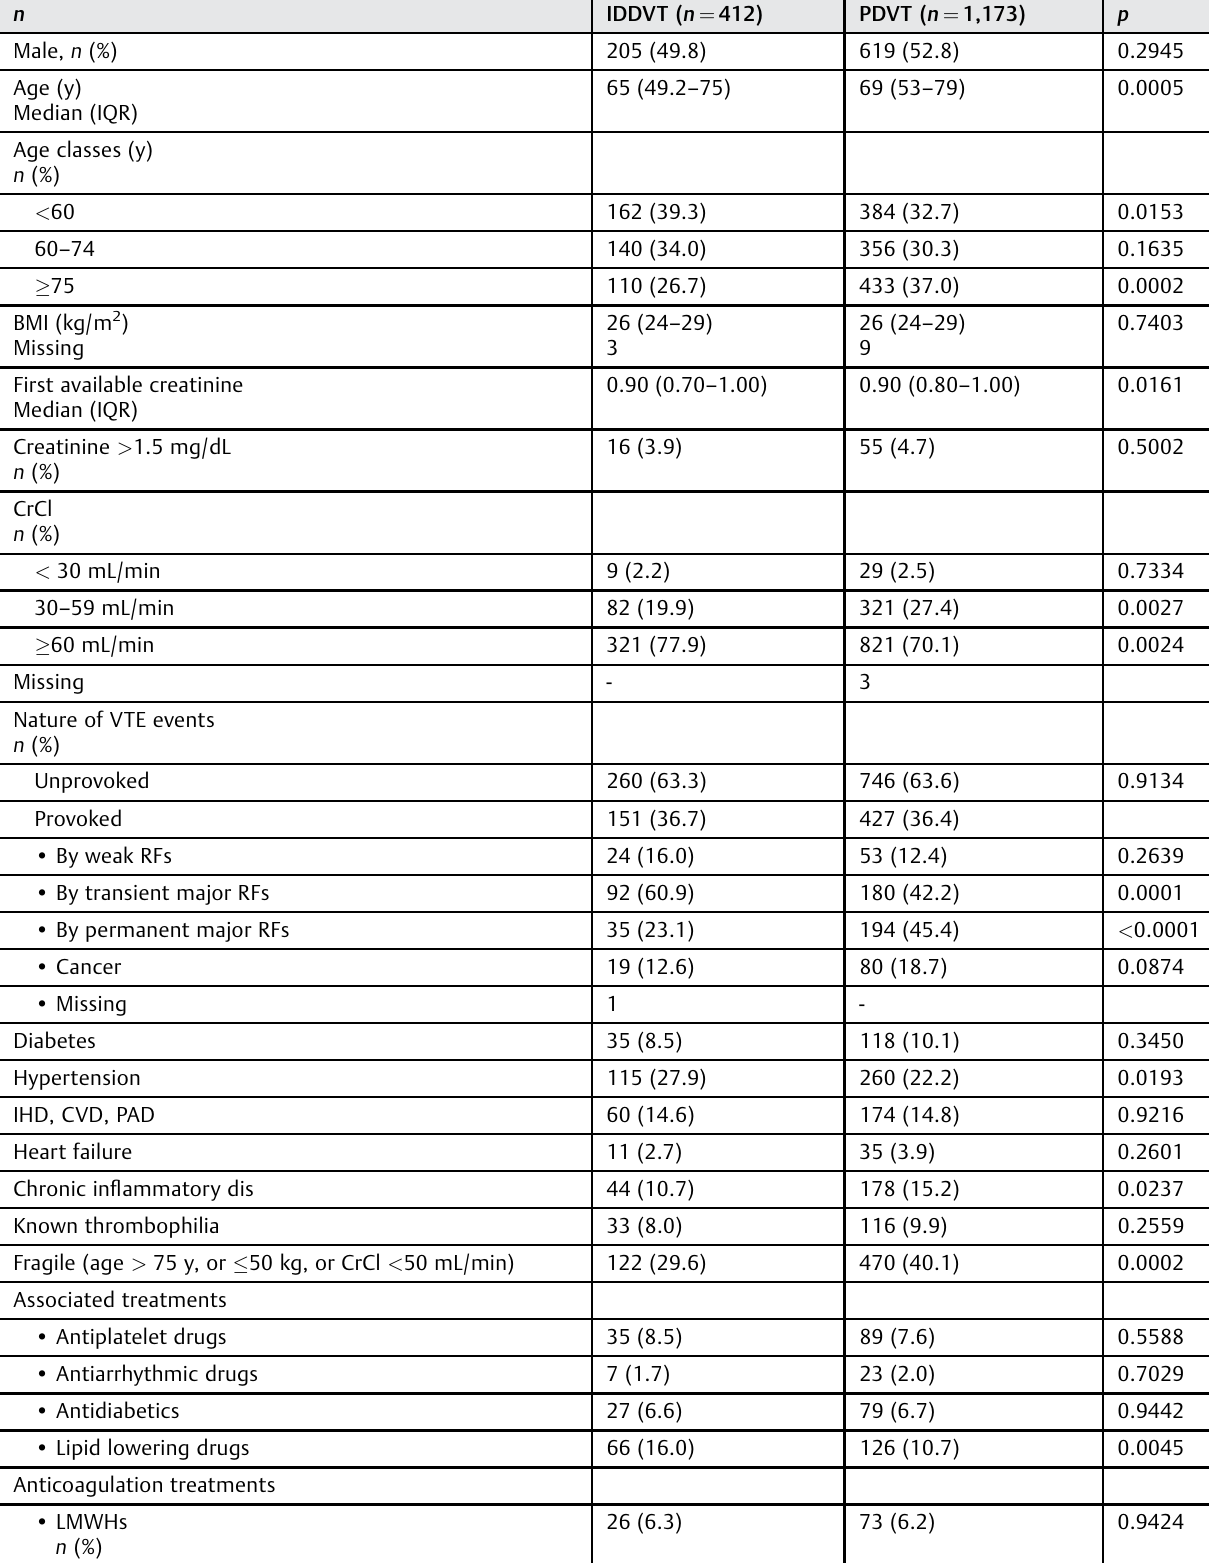
Table 1 Baseline characteristics of patients with a fi rst event of IDDVT or